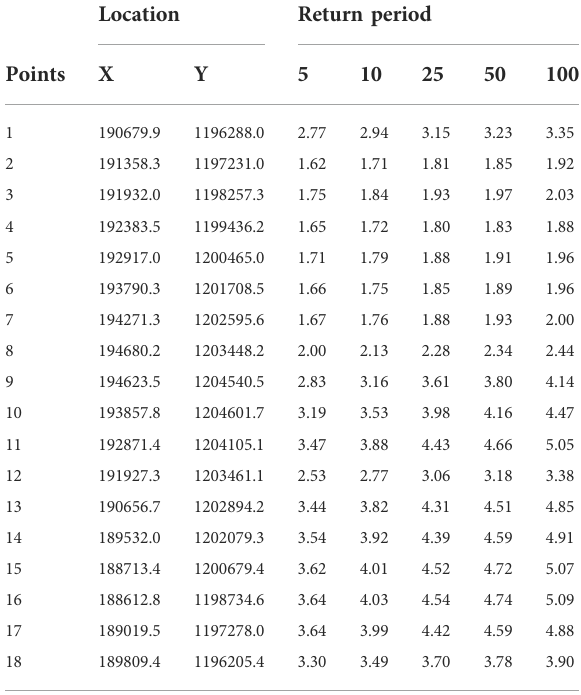
TABLE 5 Seasonal distribution of Mean wave energy fl ux for Agatti